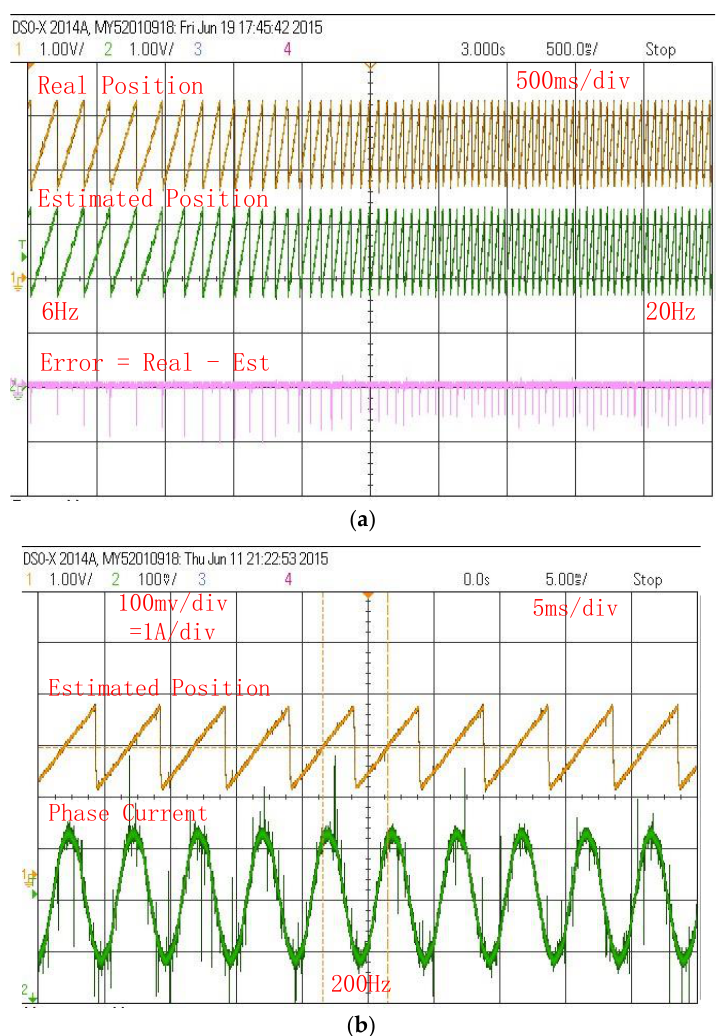
Figure 13. Rotor position estimation results. ( a ) Real position versus estimated position in transient speed change; ( b ) Estimated position and phase current in steady state performance.